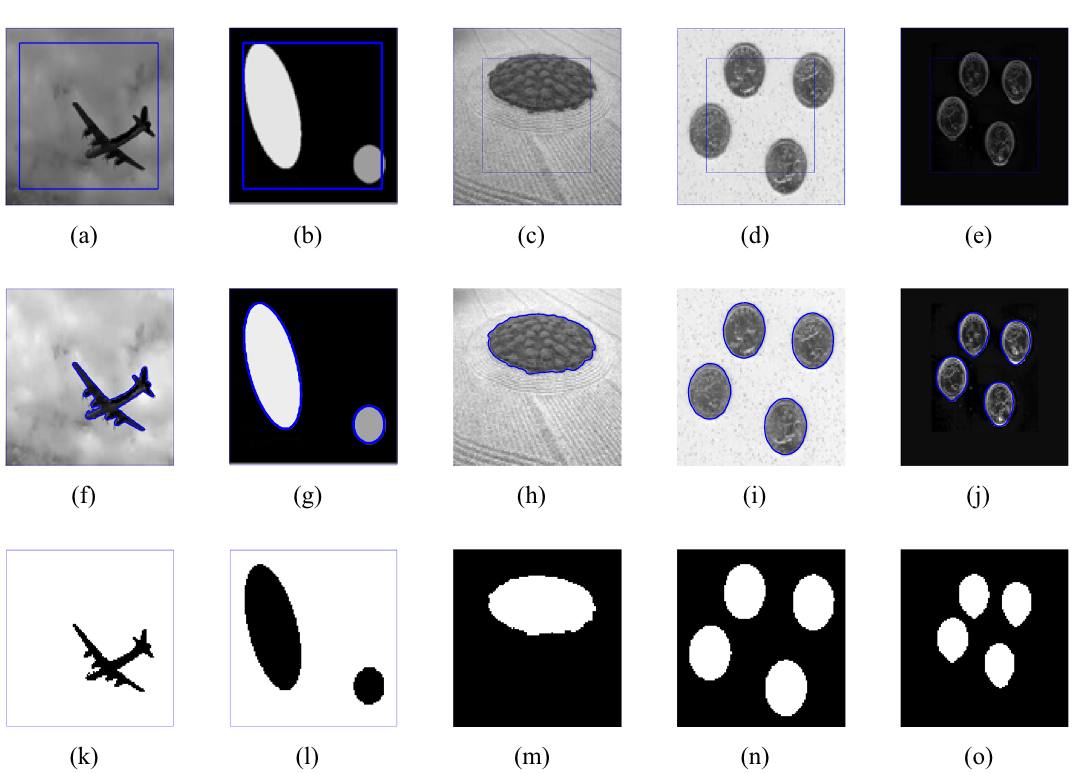
Figure 2. Performance of the proposed model for different images (Berkeley image data set) with p = 0.5 , µ = 0.7, and σ =